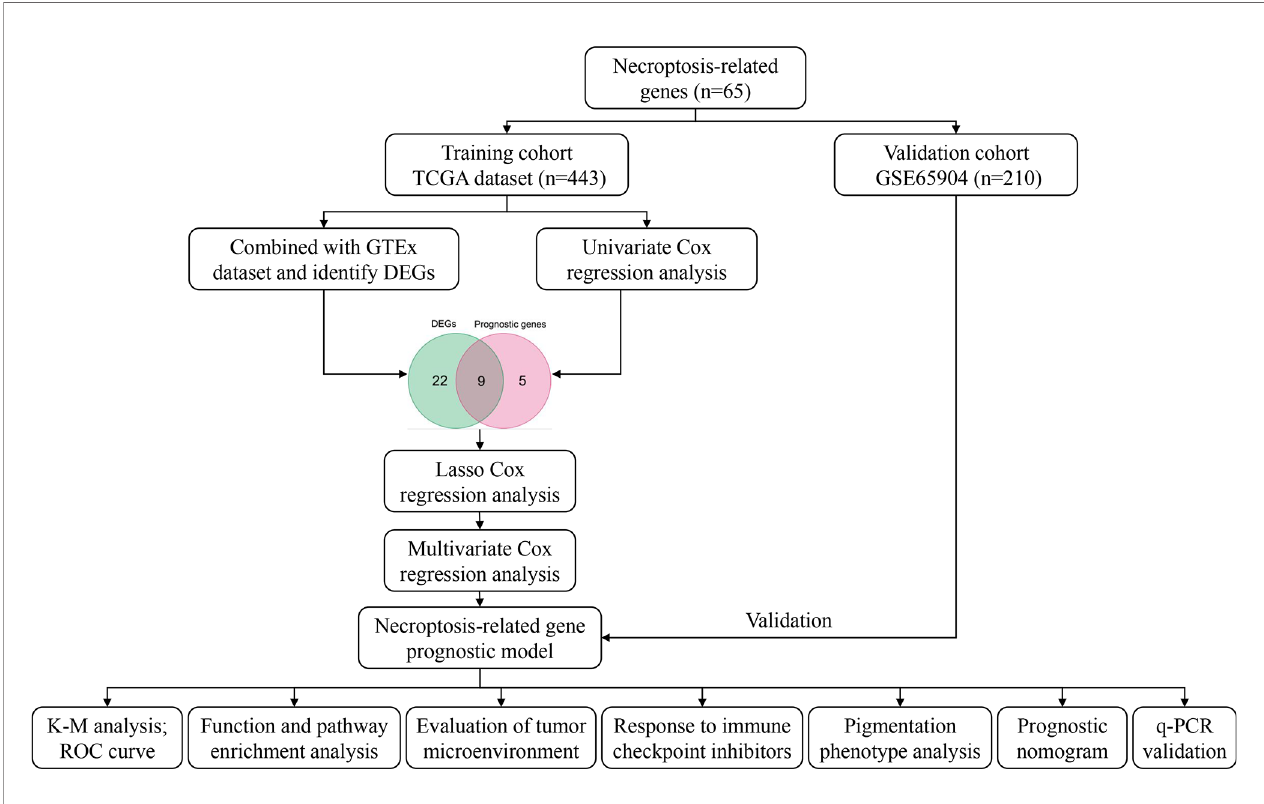
FIGURE 1 | Work fl ow